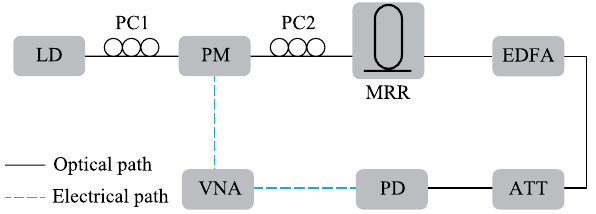
Fig. 1 Schematic diagram of the proposed MPF-based sensor sys- tem. LD laser diode, PC polarization controller, PM phase modulator, MRR micro-ring resonator, EDFA erbium-doped fiber amplifier, ATT attenuator, PD photodetector, VNA vector network